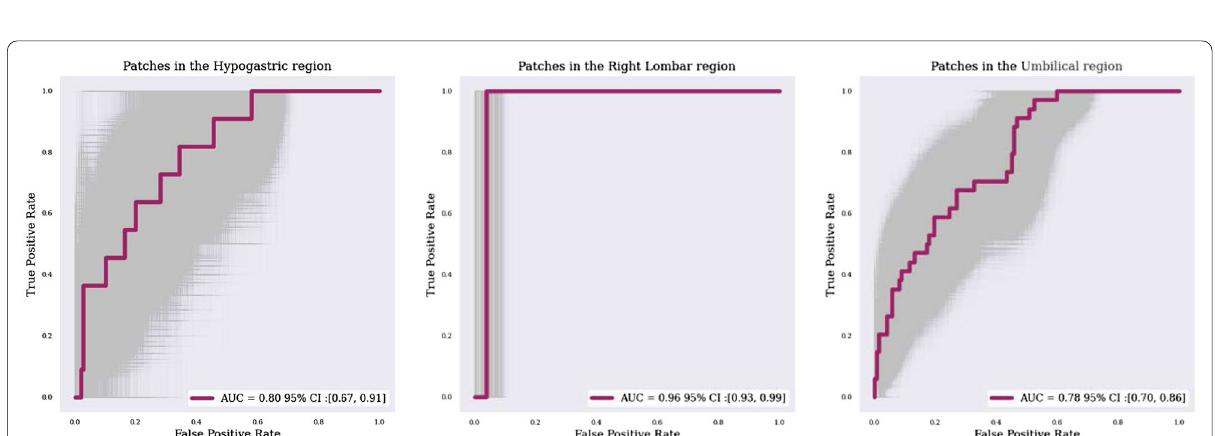
Fig. 4 AUROC curves obtained with the different divisions of the abdomino‑pelvic region. Divisions into 3 4